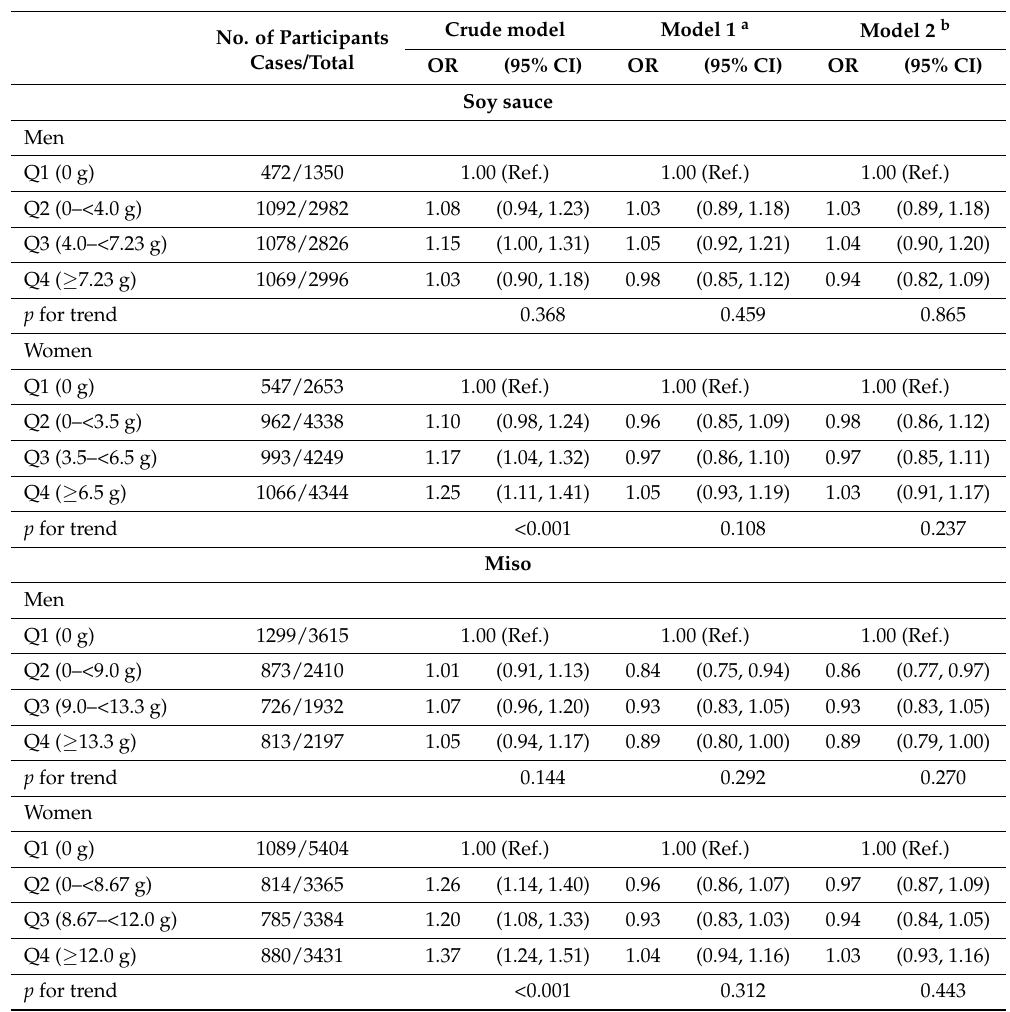
Table 6. Odds ratio of the association between the portion sizes of traditional Japanese seasonings and